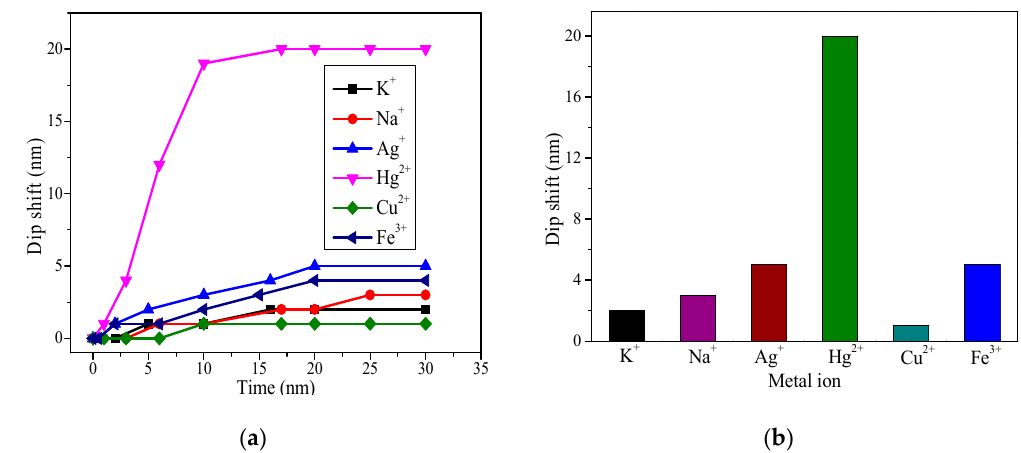
Figure 10. Resonant spectra ( a ) and wavelength shifts ( b ) of the reflective fiber SPR sensor in different metal ions.